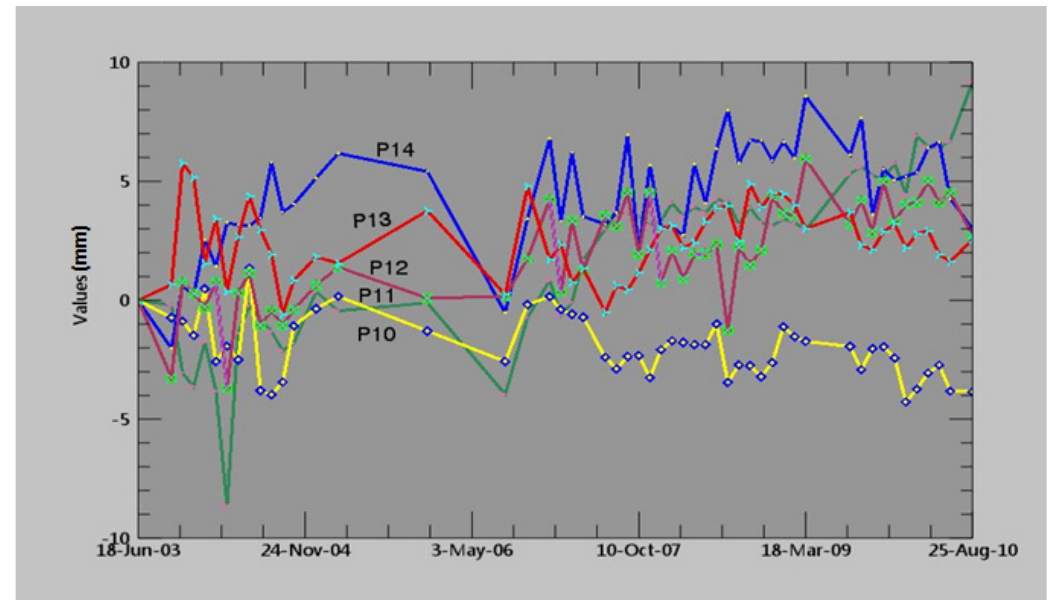
Figure 8. Displacement history for the three typical points (P10, P11, P12, P13 and P14, marked in Figure 4) within the subsidence funnel zone IV.